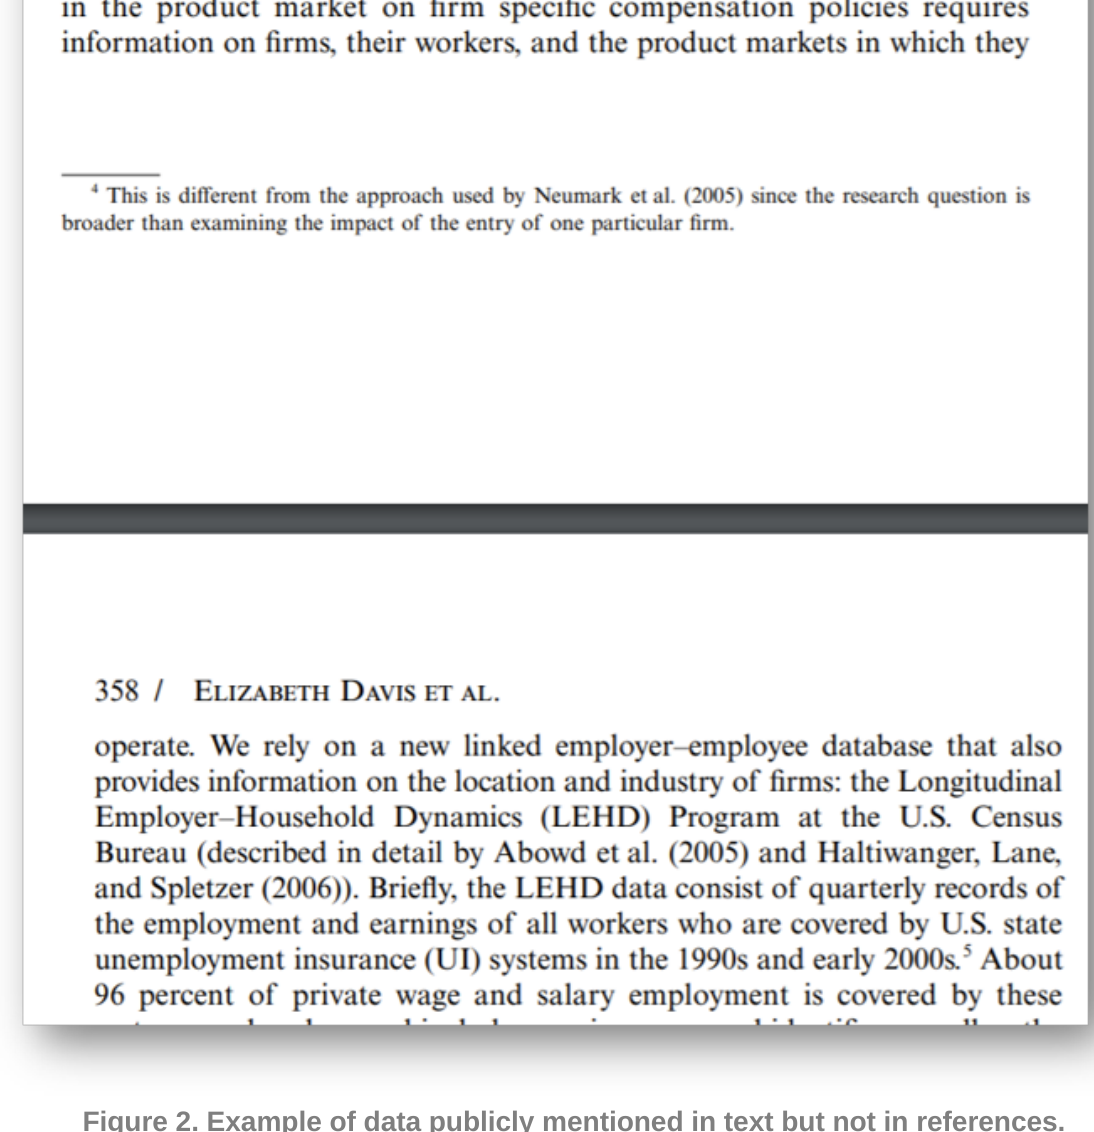
Figure 2. Example of data publicly mentioned in text but not in